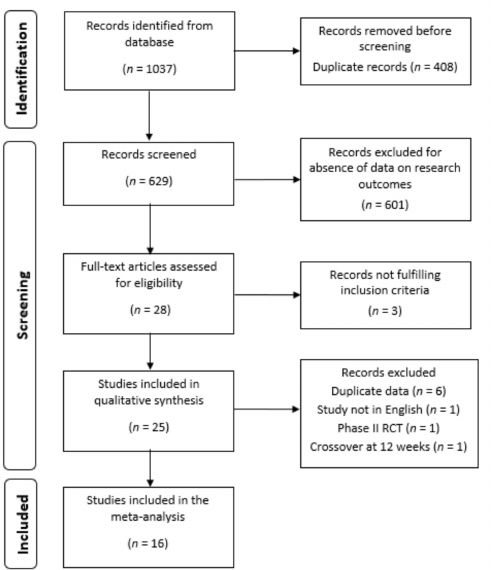
Figure 1. Study flow chart of the article selection process. RCT, randomized controlled trial. Among studies whose reference treatment was combination therapy of adalimumab originator and methotrexate (MTX), four compared adalimumab to its biosimilars [25–28], two studies compared adalimumab to tofacitinib [29,30] and one each for adalimumab compared to abatacept [31], certolizumab pegol [32], baricitinib [33], upadacitinib [34] and filgotinib [35]. Among studies whose reference treatment was adalimumab originator